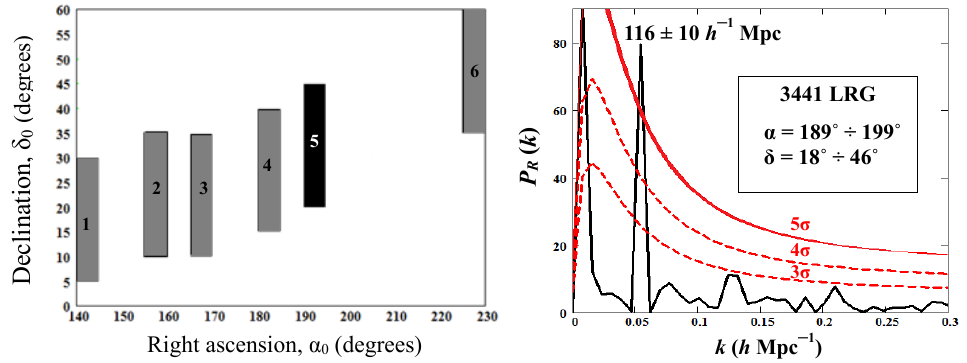
Figure 2. ( Left panel ): A total of 6 out of 144 sectors covering the entire rectangular area, which stand out due to their high peak amplitudes in the radial power spectra at k max , lying in a range 0.05 ≤ k max ≤ 0.07 h Mpc − 1 . ( Right panel ): Radial power spectrum P R ( k ) (solid line) calculated using Equation (3) for the black sector (No 5) in the left panel; dashed lines—the significance levels 3 σ , 4 σ and a narrow band − 5 σ calculated using the mock LasDamas catalog (see text); intervals of α and β as well as the sample size are indicated in the